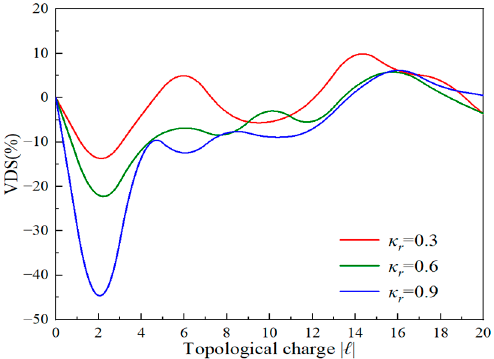
Figure 3. VDS spectra of dielectric chiral spheres with different relative chiral parameters.